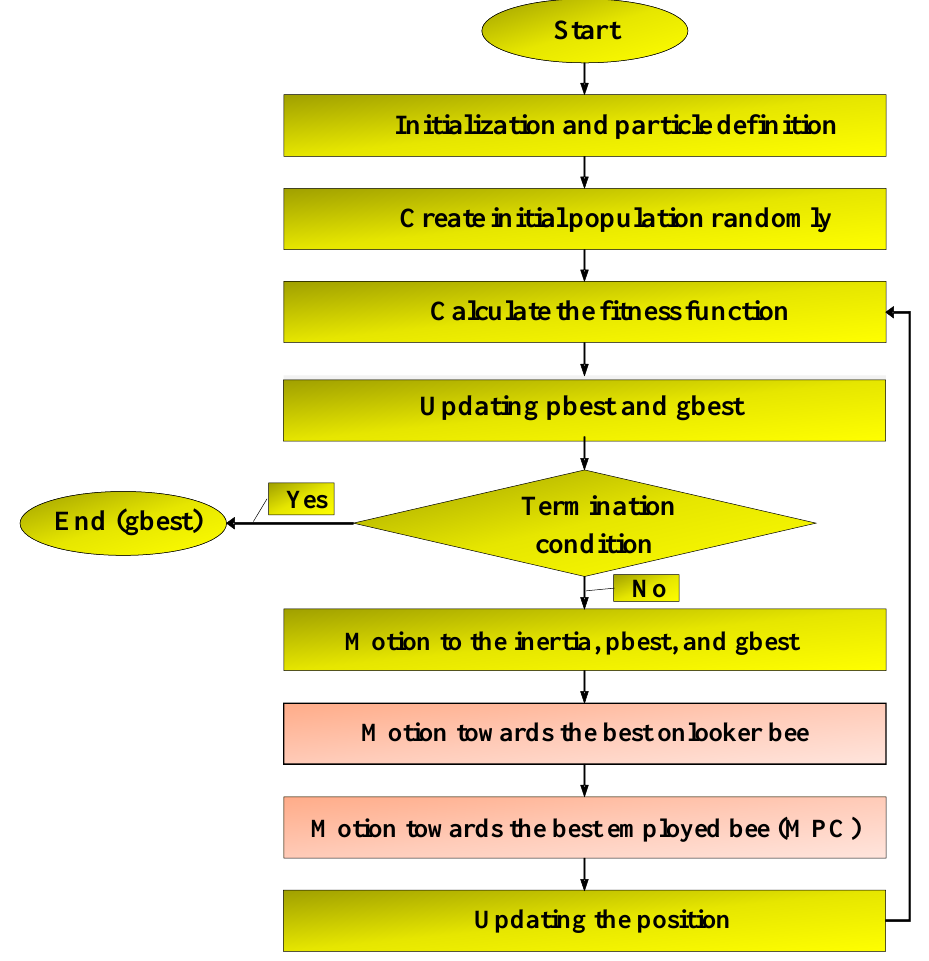
crossover operator improves the algorithm exploration. Figure 4 shows the example of the multi-parent crossover operator of the NSBPSO algorithm.